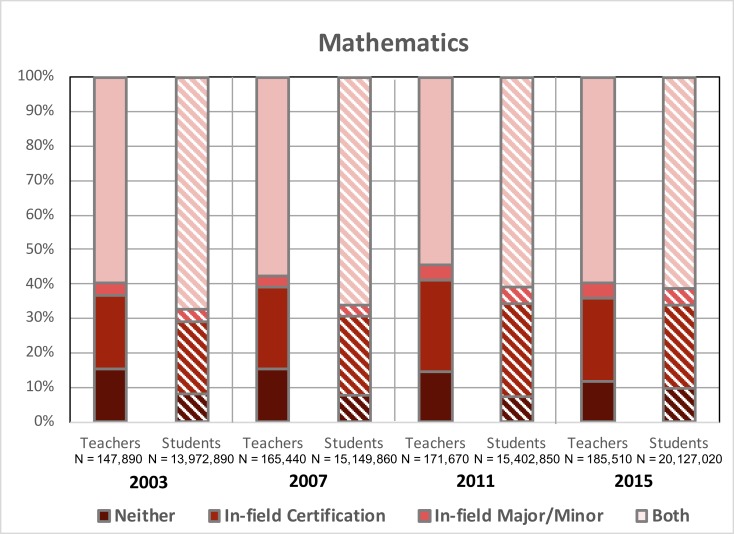
Percentages of in-field and out-of-field high school mathematics teachers and high school mathematics students assigned to these educators from 2003–2015.CVteachers < .008; CVstudents < .001; SEteachers ≤ 4%; SEstudents ≤ 1%.